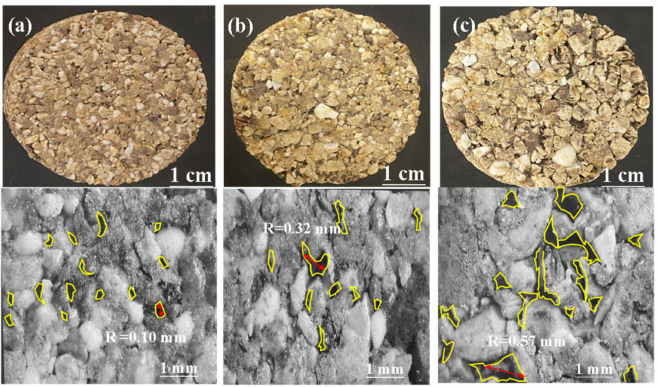
Figure 3. Optical images of the sample at 1200 ◦ C with different content of coarse aggregate: ( a ) 0%; ( b ) 50%; and ( c )